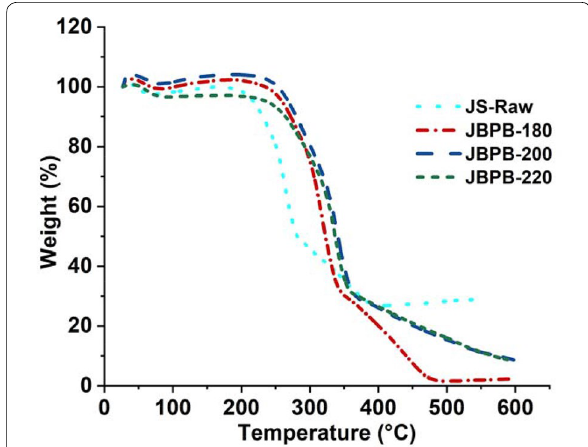
Fig. 4 Thermogravimetric (TG) curve of jute stick particles and manufactured jute stick binderless particleboard (JBPB) as a function of press